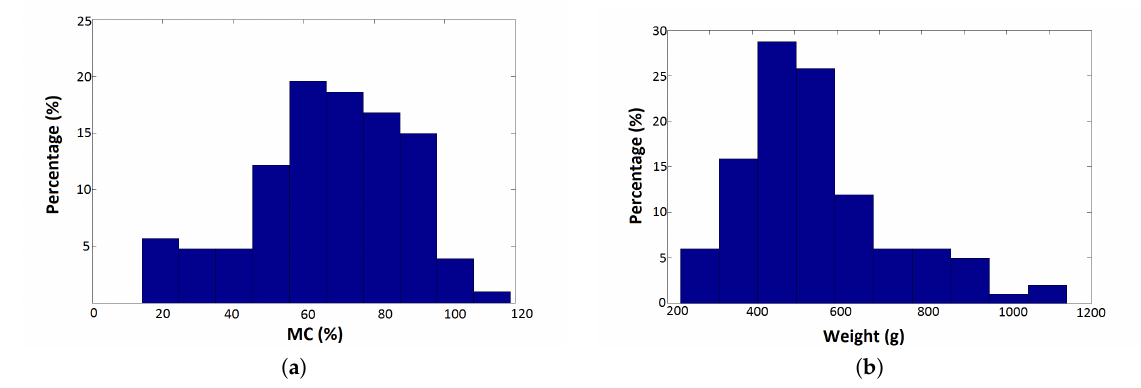
Figure 1. Distribution of sample numbers ( a ) by moisture content; and ( b ) by total (wet)